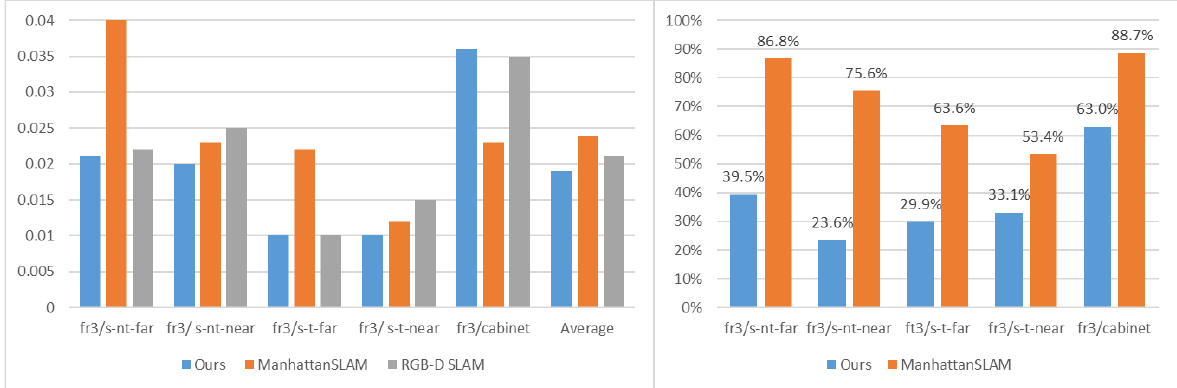
Figure 10. Left : Comparison of ATE RMSE (M) for sequence fr3/s-nt-far, fr3/s-nt-near, fr3/s-t-far, fr3/s-t-near, fr3/cabinet. Right : The percentage of MFs detected from each sequence.